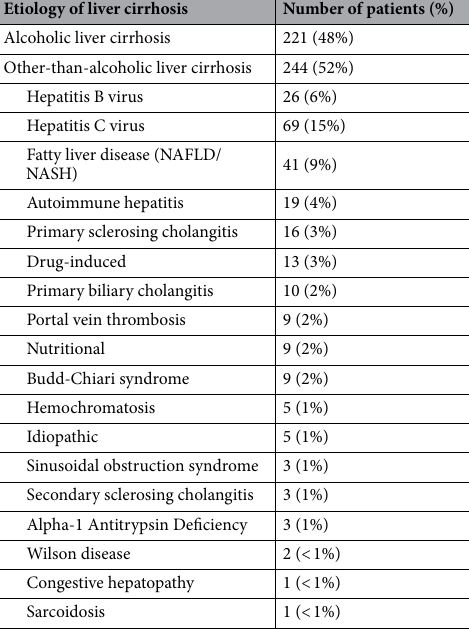
Frozen pre-trained